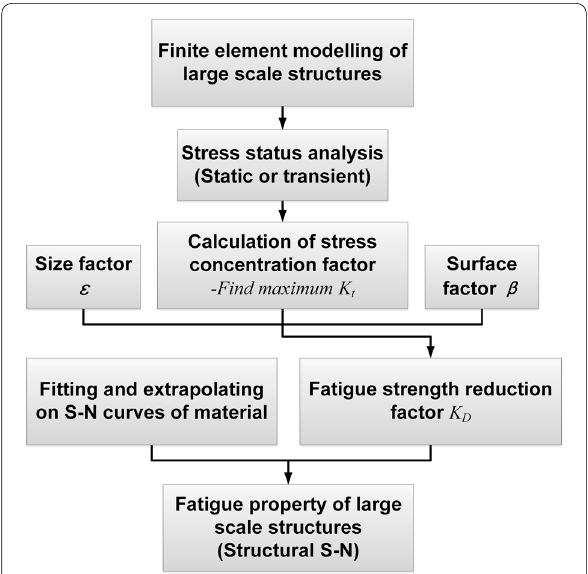
Figure 1 Workflow of fatigue characterization on a large-scale